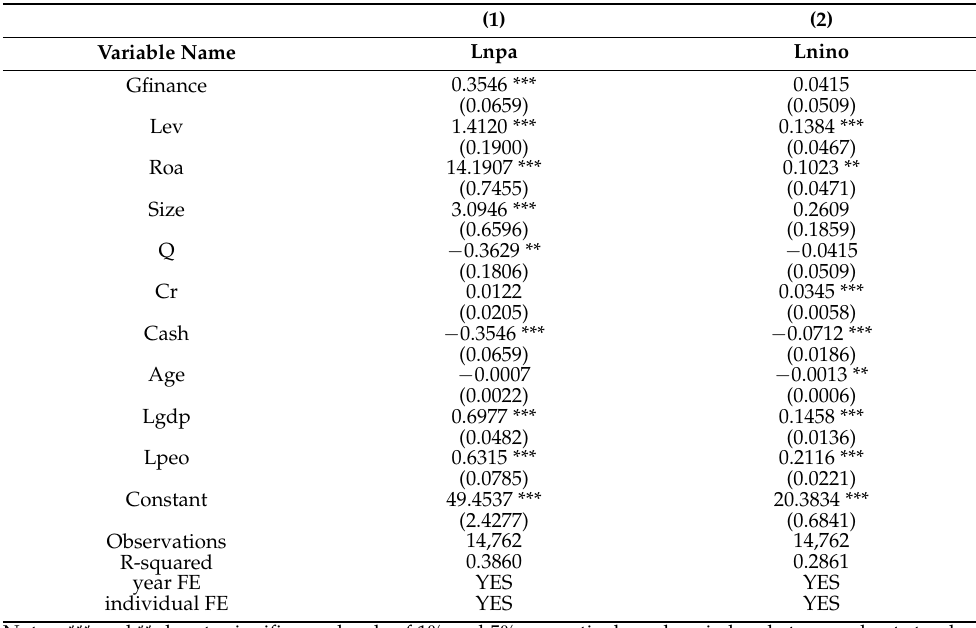
Table 8. Inspection by Central Environmental